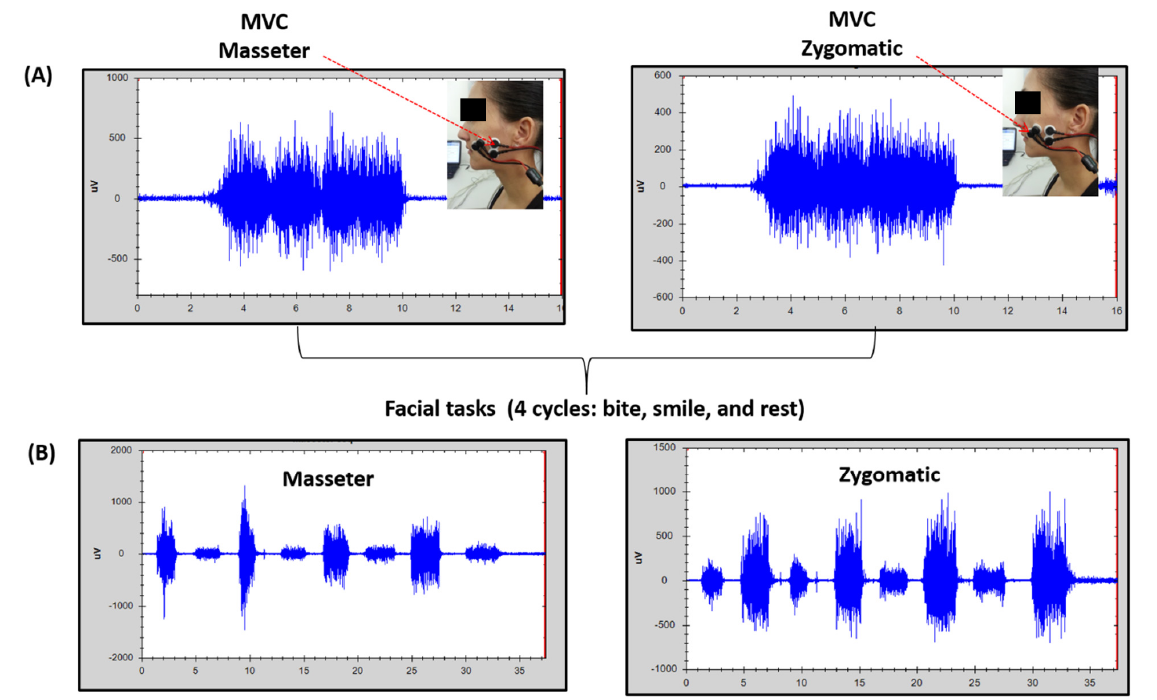
Figure 2. Representative figure showing the maximal voluntary contraction (MVC) of the masseter during bite task ( A-left ) and zygomatic during smile task ( B-right ) during 4 cycles of bite–smile–rest. Electromyography (EMG) signal was obtained during all cycles for maximal muscle activation (RMS MAX ).